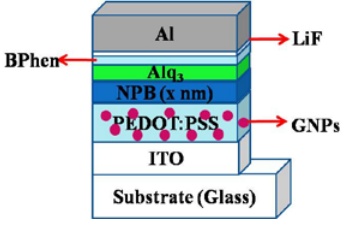
Figure 1. Schematic structure of devices with GNPs and the buffer layer.